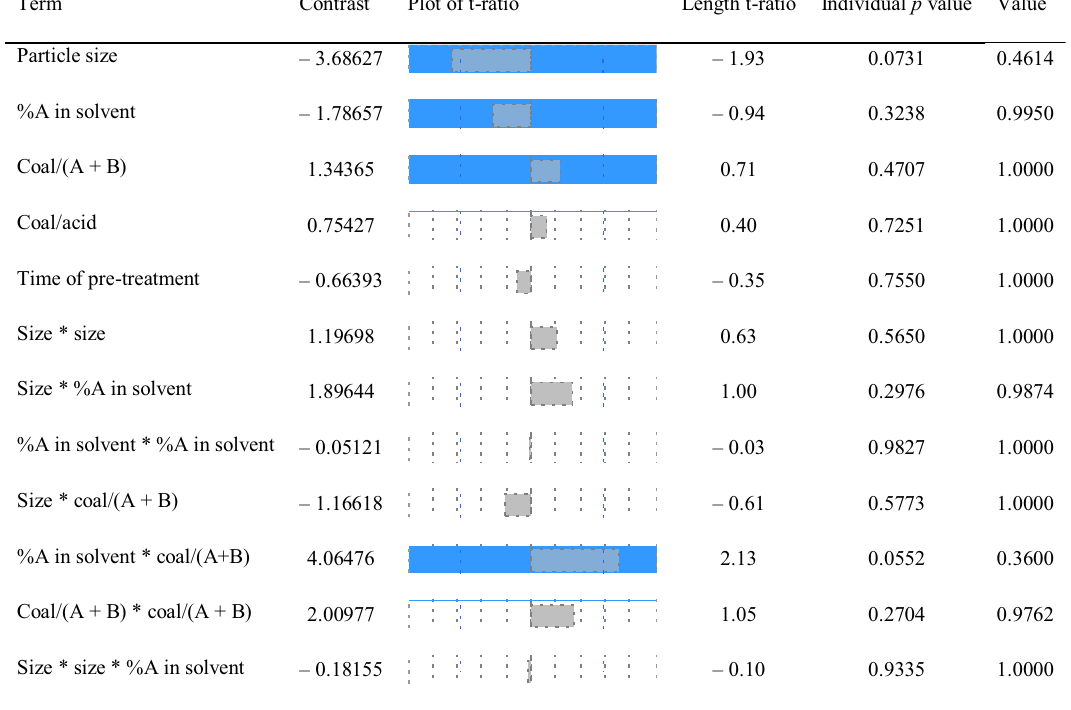
Fig. 2 Screening for five parameters of the definitive screening design (DSD). A: co-solvent (EDA) concentration, A ? B: total solvent concentration (NMP ? EDA)